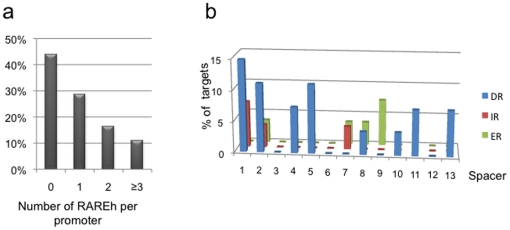
Presence of RARE in PLZF/RARA target promoters.(a) Percentage of PLZF/RARA bound regions containing 0, 1, 2, and 3 or more the core motif RGKTCA or RARE half site (RAREh). (b) PLZF/RARA target regions were scanned for the presence of Direct (DR), Inverse (IR) or Everted (ER) RARE repeats with a maximum spacer length of 13 nucleotides. The % of target promoters as a function of spacer length is plotted.